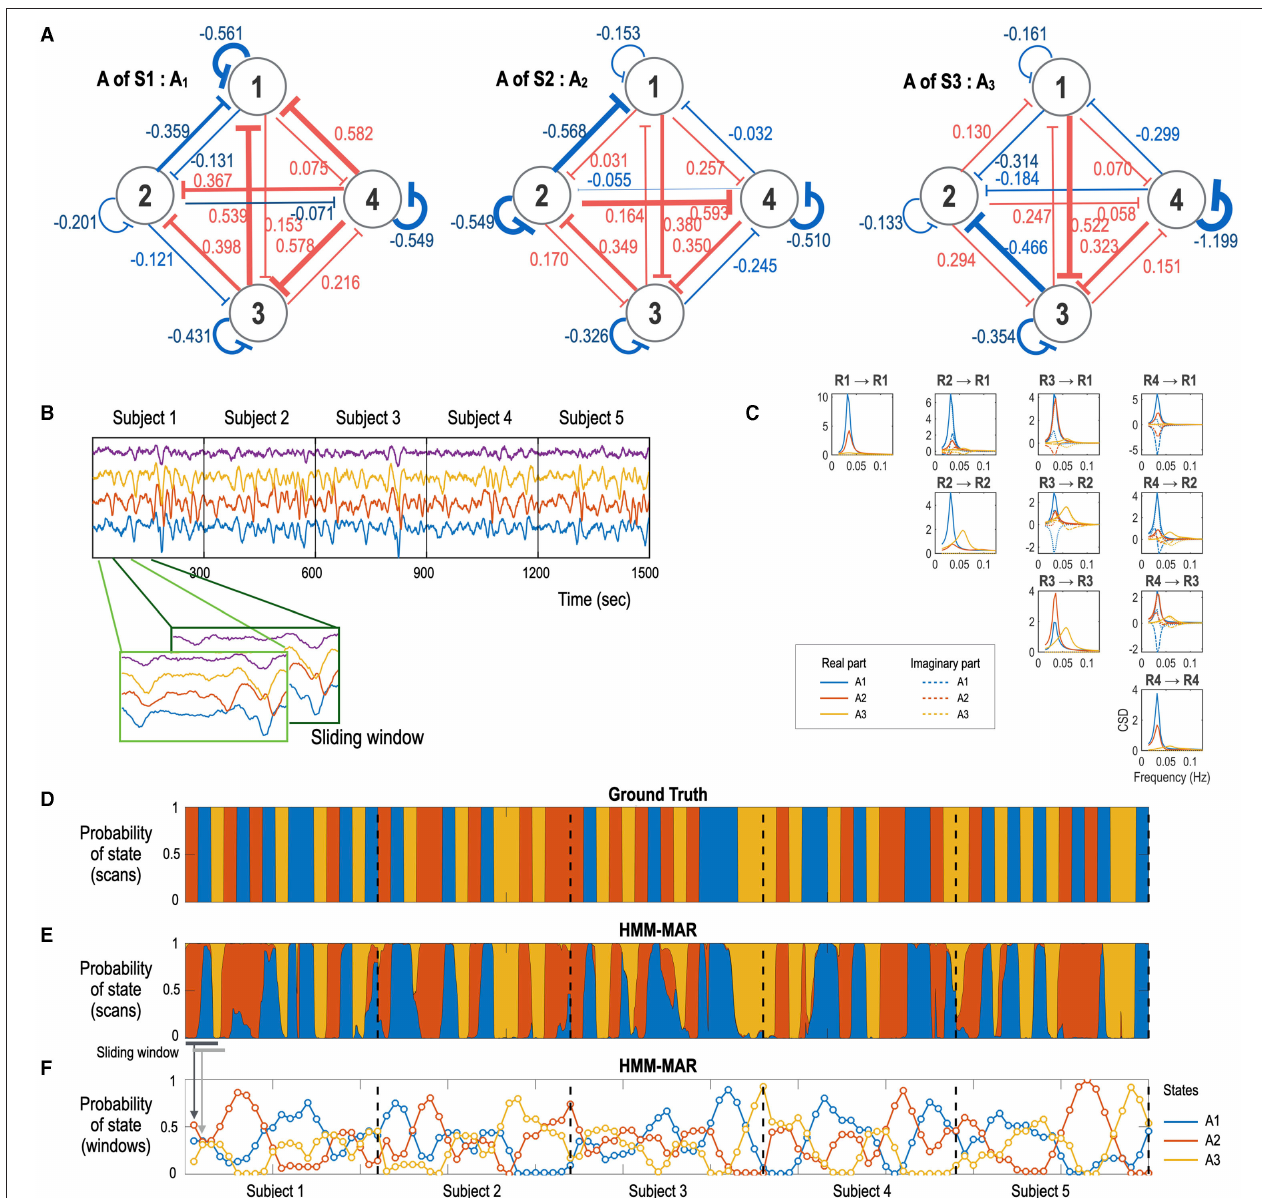
FIGURE 2 | Simulation study with a time series generation and state-sequence estimation using HMM-MAR. (A) A network system with three different effective connectivity states, A1 (A matrix in Eq. 3 for the state S1), A2 (A matrix for the state S2), and A3 (A matrix for the state S3), used in this simulation are displayed. (B) fMRI signals with 300s length (TR = 0.8s, total 375 samples) were generated according to the dynamic equation in Eqs. 3–4 for five subjects by transitioning the three effective connectivity matrices. (C) the cross-spectral density for the three effective connectivity states is presented in blue, red, and yellow colors for A1, A2, and A3, respectively. (D, E) The ground-truth state sequence (D) and the estimated state sequence (E) obtained by the HMM-MAR analysis with K = 5 and order = 5. Only three clusters dominated the entire time for all the subjects. The blue, red, and yellow represent the three dominant effective connectivity states A1, A2, and A3. The occupation indices (or occupation times divided by the window size) of the three major states for each sliding window for (E) are displayed at (F) . The state-dependent effective connectivity analysis is based on these estimated occupation indices as a state sequence.